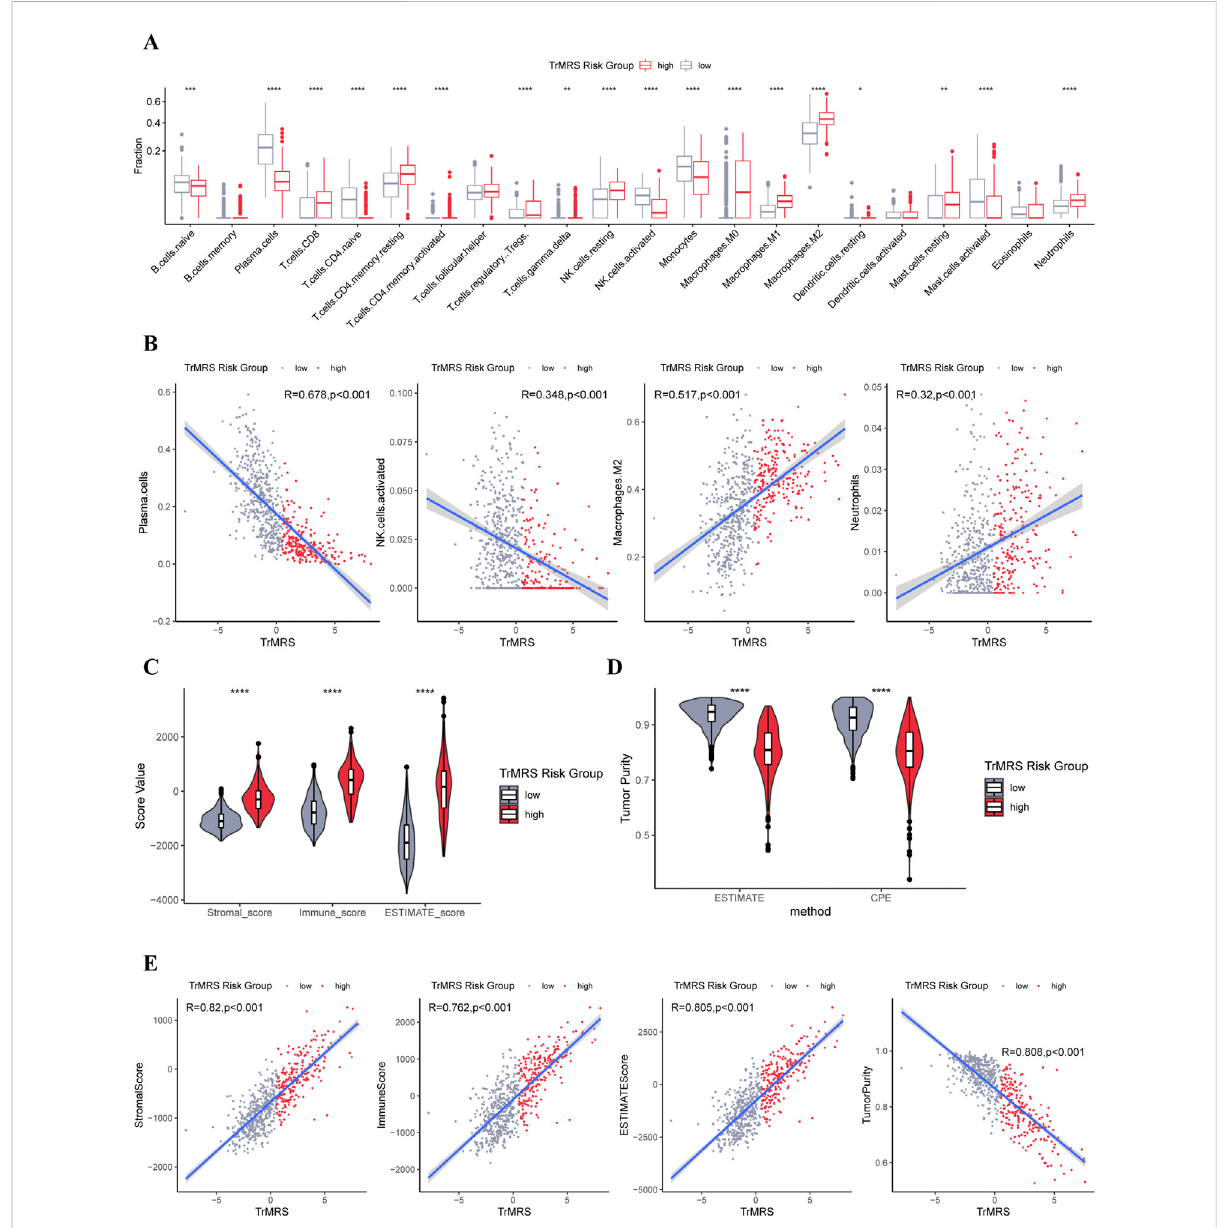
FIGURE 8 Differences in immune features of tumor microenvironment between two TrMRS risk groups. (A) Boxplot of the estimated fraction of 22 immune cells in tumors (low-risk group: N = 429, high-risk group: N = 226). (B) Analyses of correlations of TrMRS with the in fi ltration of plasma cells, activated NK cells, M2 macrophages, and neutrophils ( N = 655). (C) Differences in the stromal, immune, and ESTIMATE scores of the two risk groups. (D) Tumor purity of the two risk groups based on the ESTIMATE and CPE algorithms. (E) Analyses of correlations of TrMRS with the stromal, immune, ESTIMATE score, and tumor purity. * p < 0.05; ** p < 0.01; *** p < 0.001; **** p <